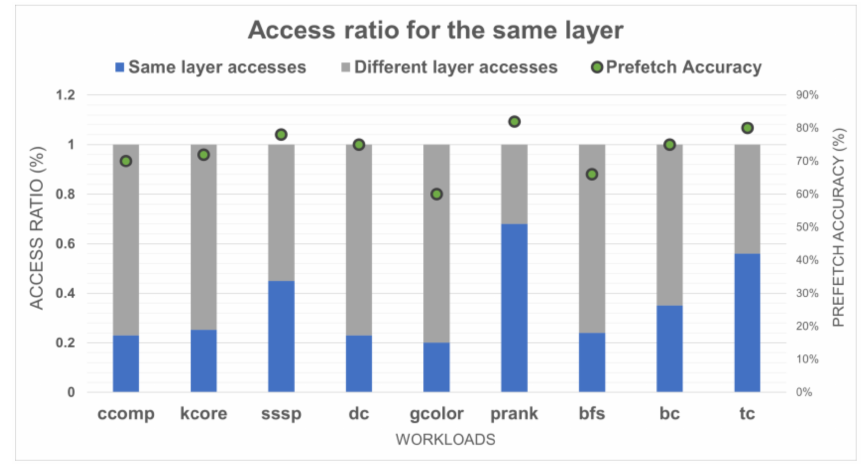
Figure 16. Access ratio of the same correlated line.